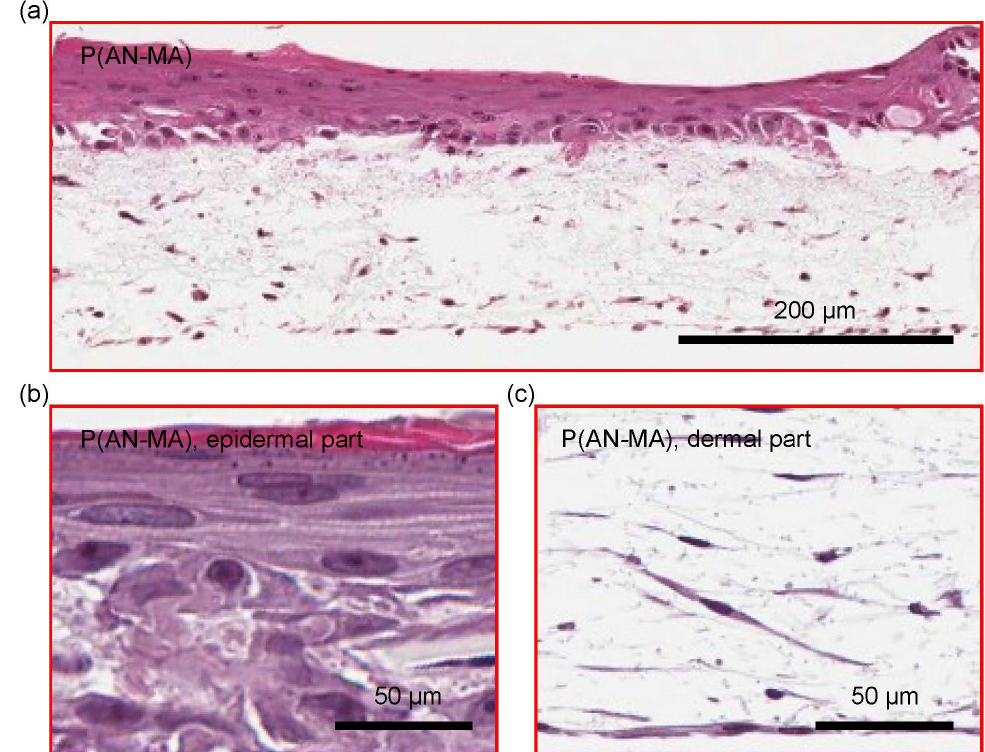
Figure 7. H/E staining of the 3D skin cell model with primary skin cells grown on P(AN-MA) electrospun nanofiber mats for 21 days showing skin FBs in the dermal part and keratinocytes building the epidermis-like structure. In ( a ) the entire skin cell model is shown including the epidermal and dermal part; ( b , c ) are close-up view of the epidermal and dermal part, respectively.